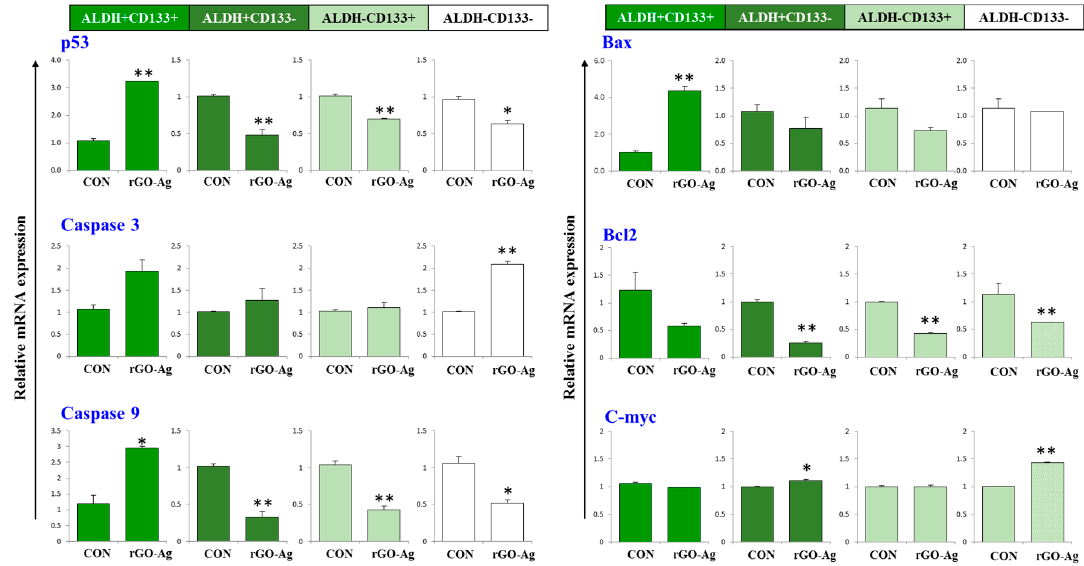
Figure 7. Impact of rGO–Ag on expression of apoptosis-regulated genes in OvCSCs. Relative mRNA expression of various apoptotic genes was analyzed by qRT-PCR in OvCSCs after treatment with rGO–Ag (2 µg/mL) for 24 h ( A , B ). The results are expressed as the mean ± standard deviation of three separate experiments. The treated groups showed statistically significant differences from the control group according to Student’s t -test (* p < 0.05, ** p < 0.01).